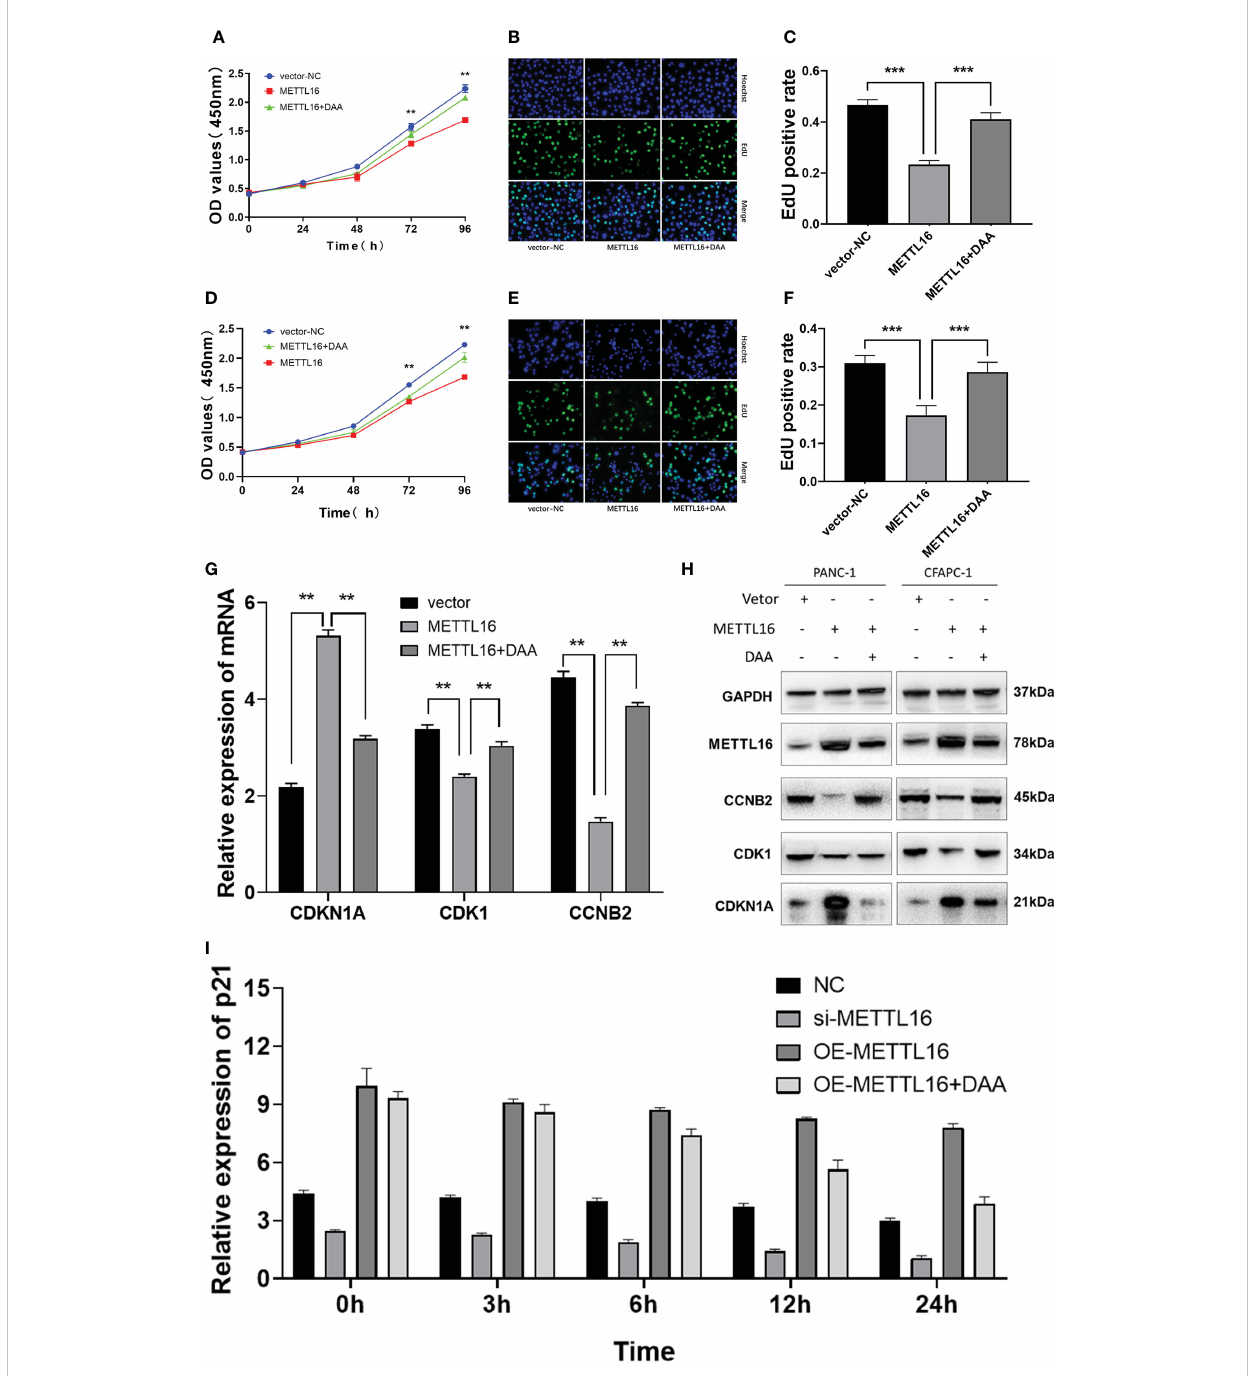
FIGURE 6 METTL16 regulates the m6A modi fi cation of CDKN1A to inhibit the proliferation of PC. Overexpression of METTL16 signi fi cantly inhibited cell growth according to CCK8 cell viability and EdU assays, and DAA administration rescued the proliferative capacity of both SW1990 (A – C) and CFPAC-1 cells (D – F) . (G) RT − qPCR showed that METTL16 overexpression modulated the mRNA levels of CDKN1A, CDK1 and CCNB2, while DAA administration restored their levels. (H) Western blotting analysis was performed to detect CDKN1A, CDK1 and CCNB2 expression in SW1990 and CFPAC-1 cells treated with METTL16-vector and DAA. (I) The stability of RNA level of CDKN1A was signi fi cantly decreased after the addition of DAA. ** means p value < 0.01, *** means p value <